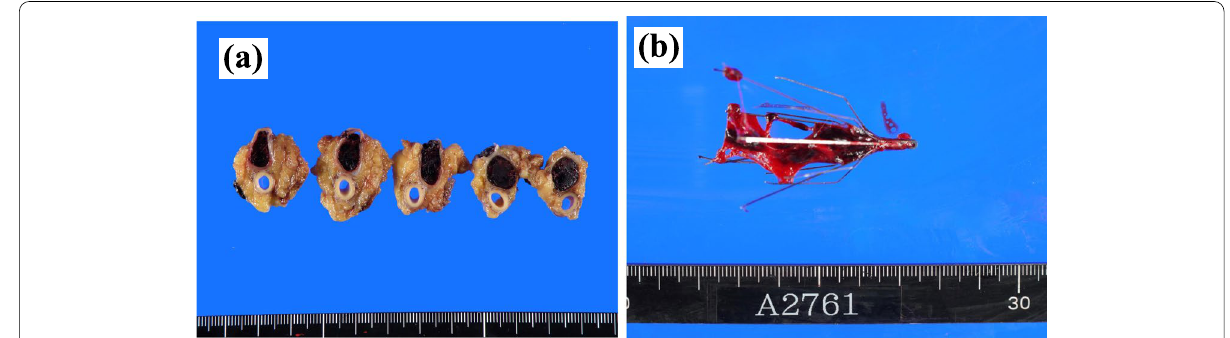
Fig. 3 Pathological specimen of a right femoral vein and b inferior vena cava filter. Note the embolism and occlusion in the right femoral vein and inferior vena cava, in contrast to the intact femoral